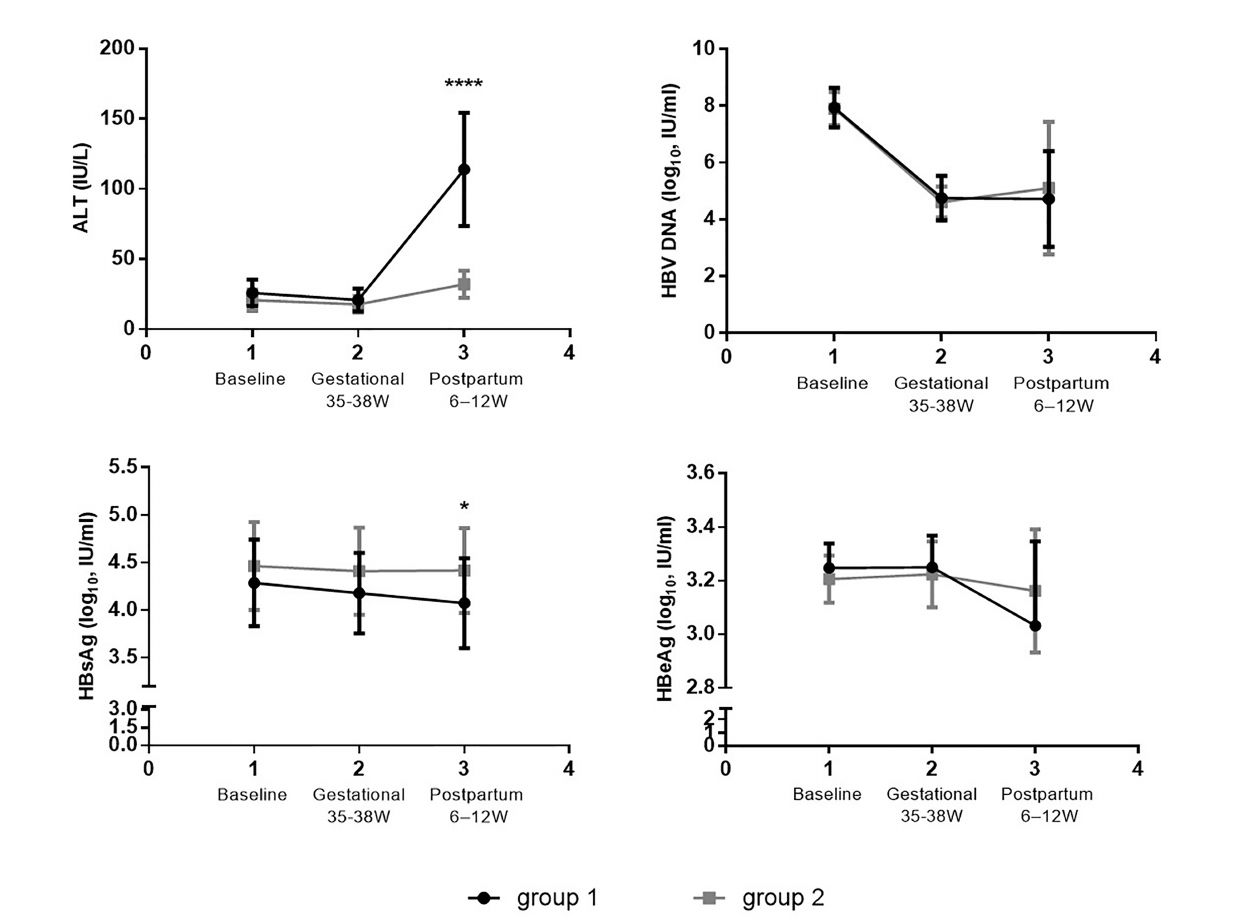
FIGURE 1 | clinical features between the two groups. Compared the difference of the levels of ALT, HBV DNA, HBsAg and HBeAg at each follow-up point between the group 1 (n=15) and group 2 (n=10). *p < 0.05, ****p <